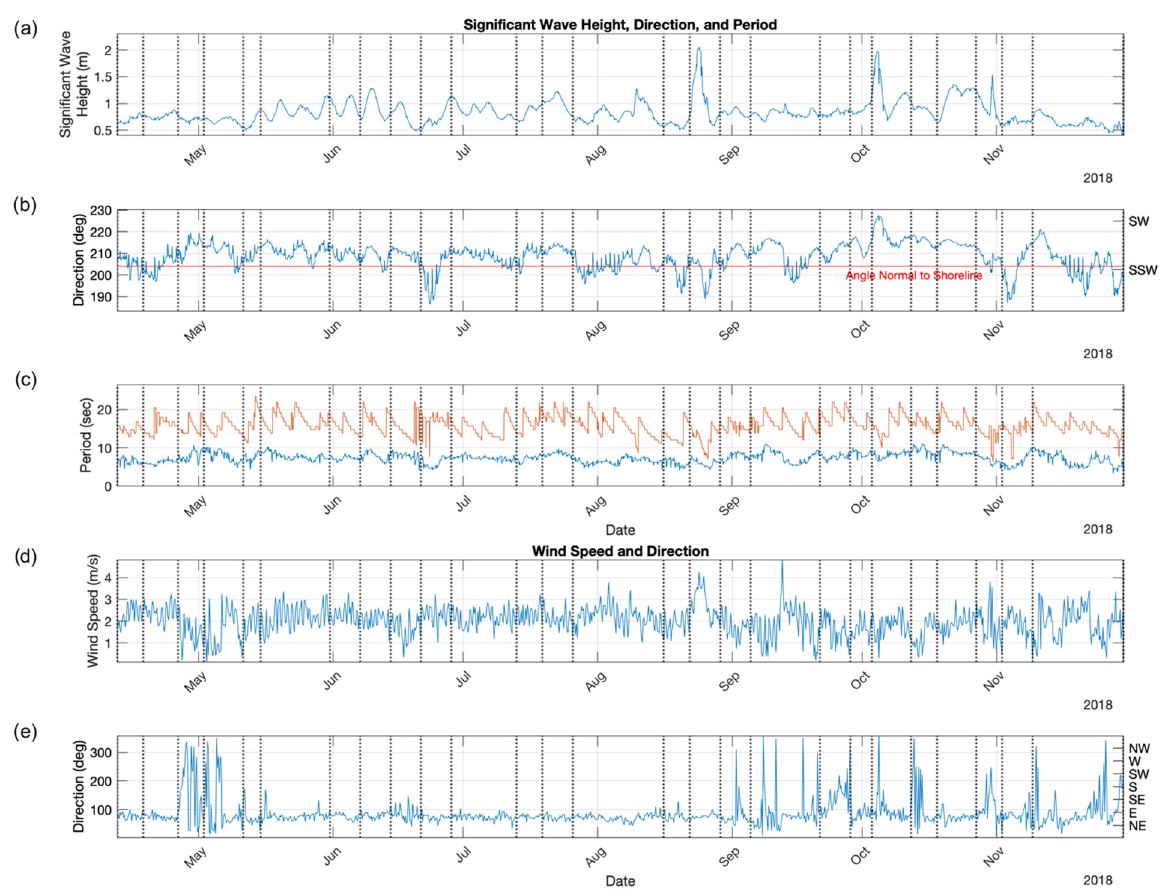
Figure 4. Wave (height, direction, and period; ( a – c )) and wind (direction and speed; ( d , e )) conditions for the study period. Wave and wind data were obtained from PacIOOS model output for the nearest grid cell proximal to the study area following Habel et al. (2016) [6]. Days on which surveys were conducted are delineated by dotted vertical